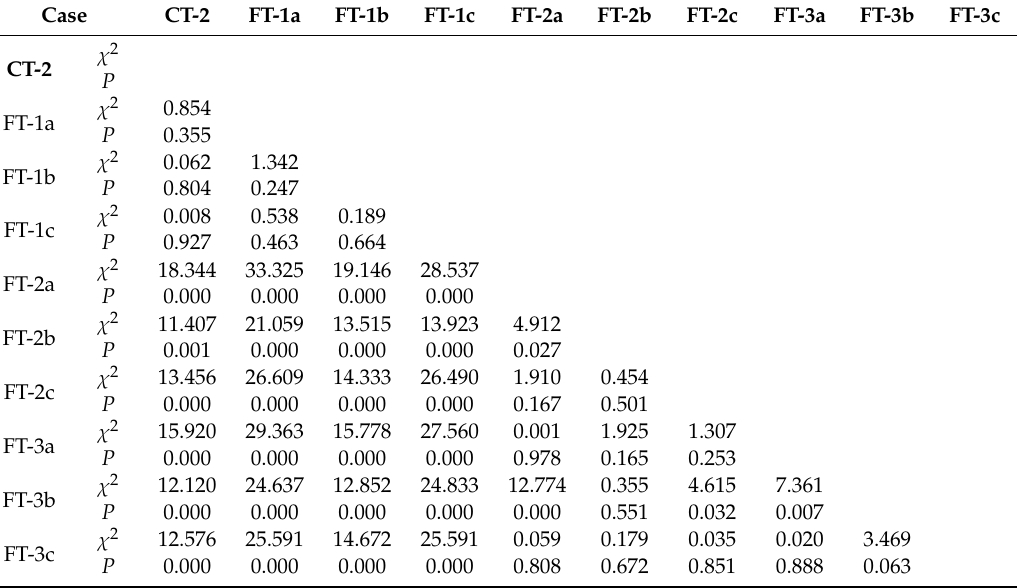
Table 4. Result of the log-rank Mantel–Cox tests between